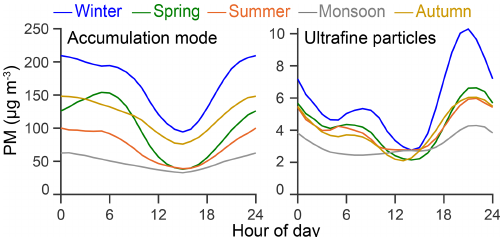
Figure 4. Average mass concentrations of observed accumulation mode (100–560nm) and ultrafine particles ( < 100nm) by season and time of day. Estimation of mass concentrations based on as- sumed particle density of 1.6gcm − 3